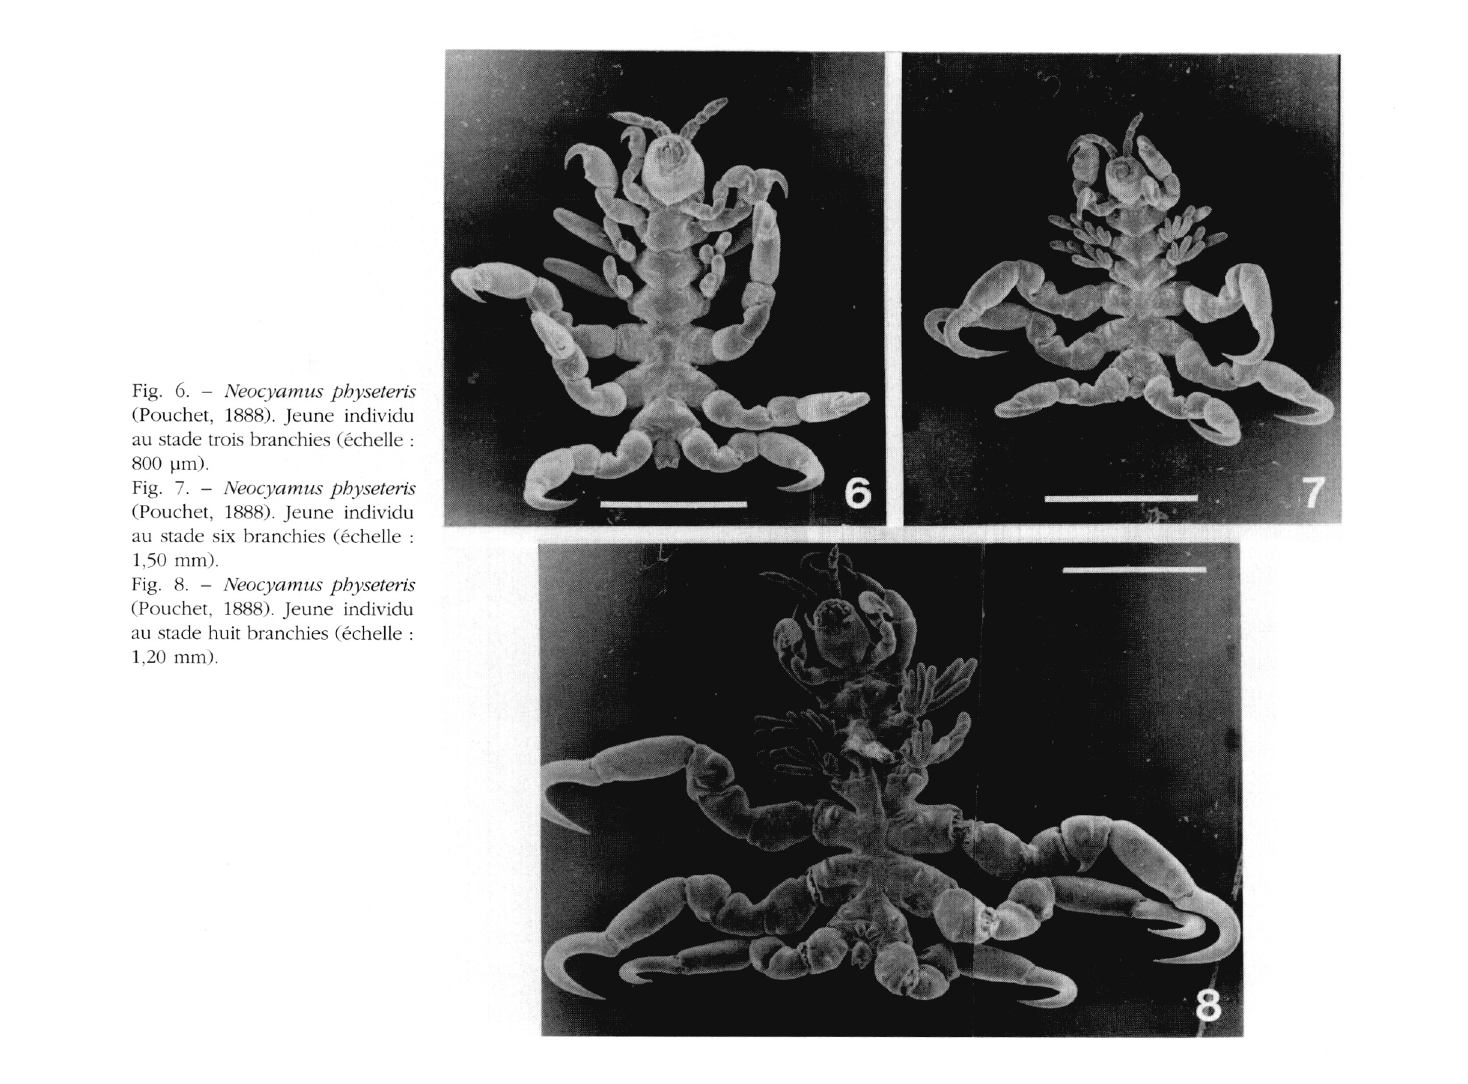
Fig. 6. - Neocyamus physeteris (Pouchet, 1888). Jeune individu au stade trois branchies (échelle : 800 pm). Fig. 7. - Neocyamus physeteris (Pouchet, 1888). Jeune individu au stade six branchies (échelle : 1,50 mm). Fig. 8. - Neocyamus physeteris (Pouchet, 1888). Jeune individu au stade huit branchies (échelle : 1,20